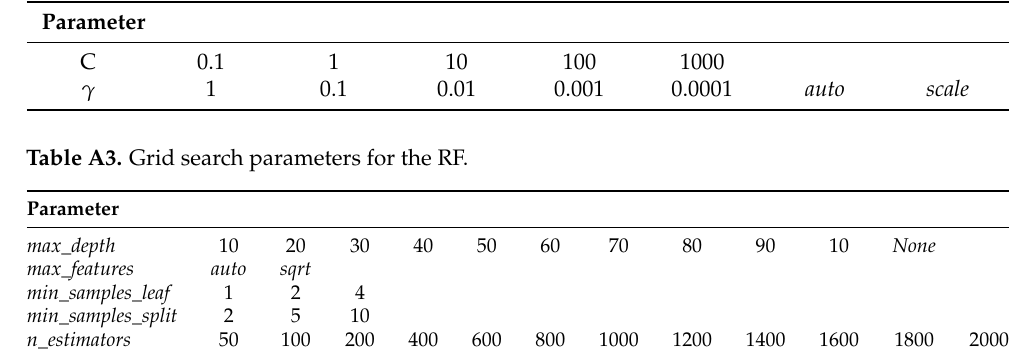
Table A2. Grid search parameters for the SVM with Gaussian (rbf) kernel.